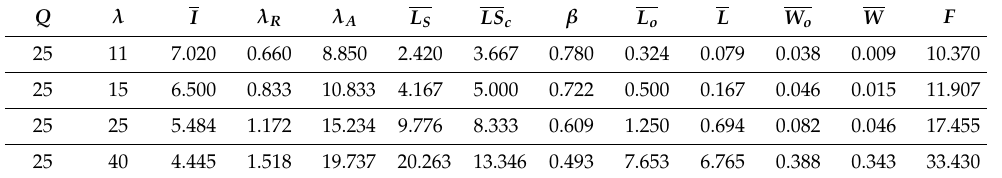
Table 3. The effect of λ on performance measures at Q = 25.